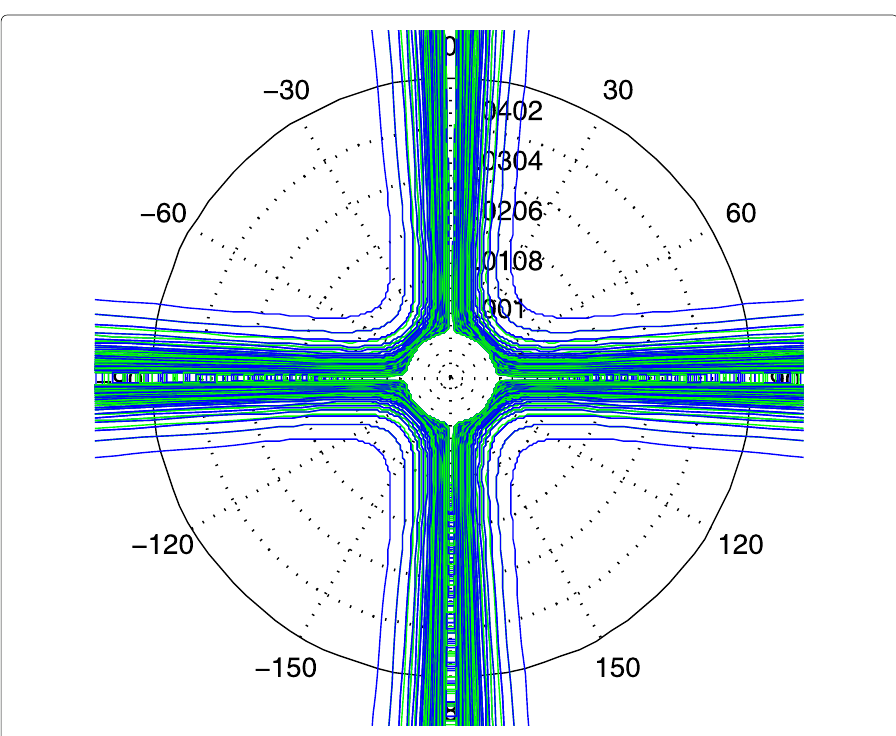
Fig. 8 Bounds of phase estimation as a function of the number of antenna elements in the URA OFDM transmissions. However, when the path separation gets larger, the bulge becomes negligible.